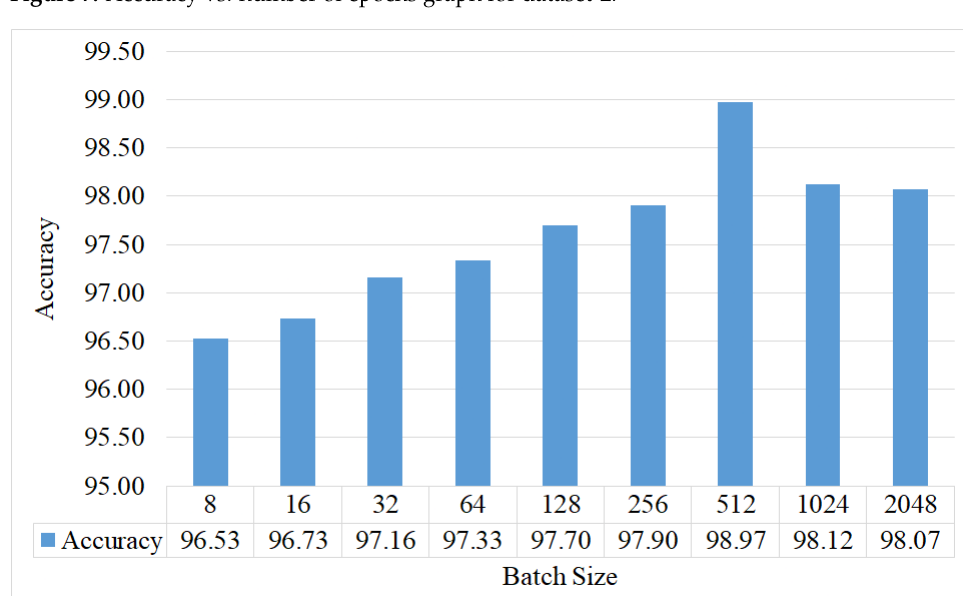
Figure 8. Accuracy vs. batch size graph for